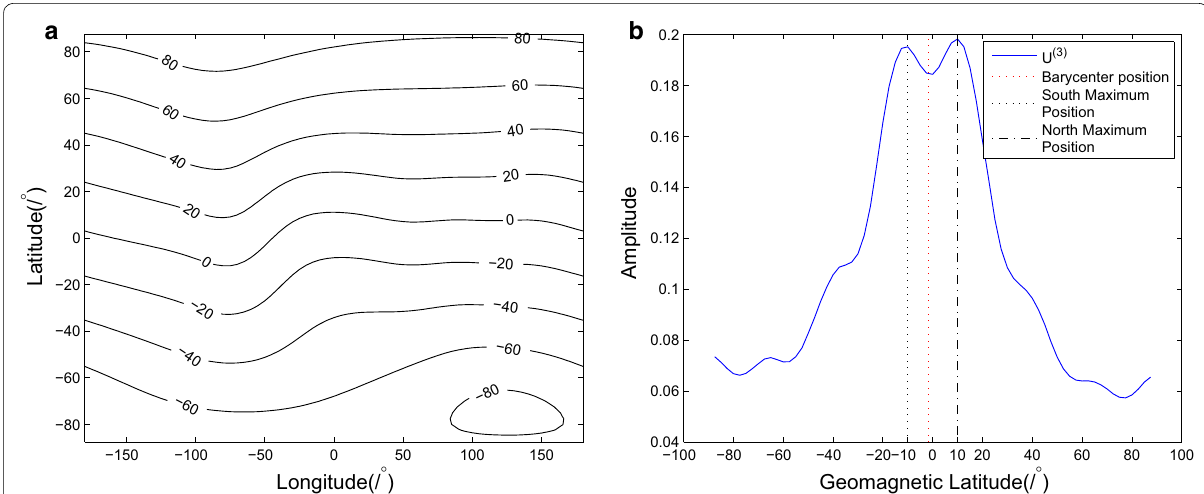
Fig. 5 Large-scale latitudinal variations in the ionosphere in geomagnetic coordinates. a The geomagnetic latitudes based on apex in the geo- graphic coordinate system. b The latitudinal variation achieved by rank-1 decomposition distributed versus the geomagnetic latitude based on apex. The red, black dotted, and black dotted dash lines indicate the positions of the barycenter, and south and north maximum of U ( 3 ) , respectively. The x-axis is the geomagnetic latitude ranging from − 87.5 ◦ to 87.5